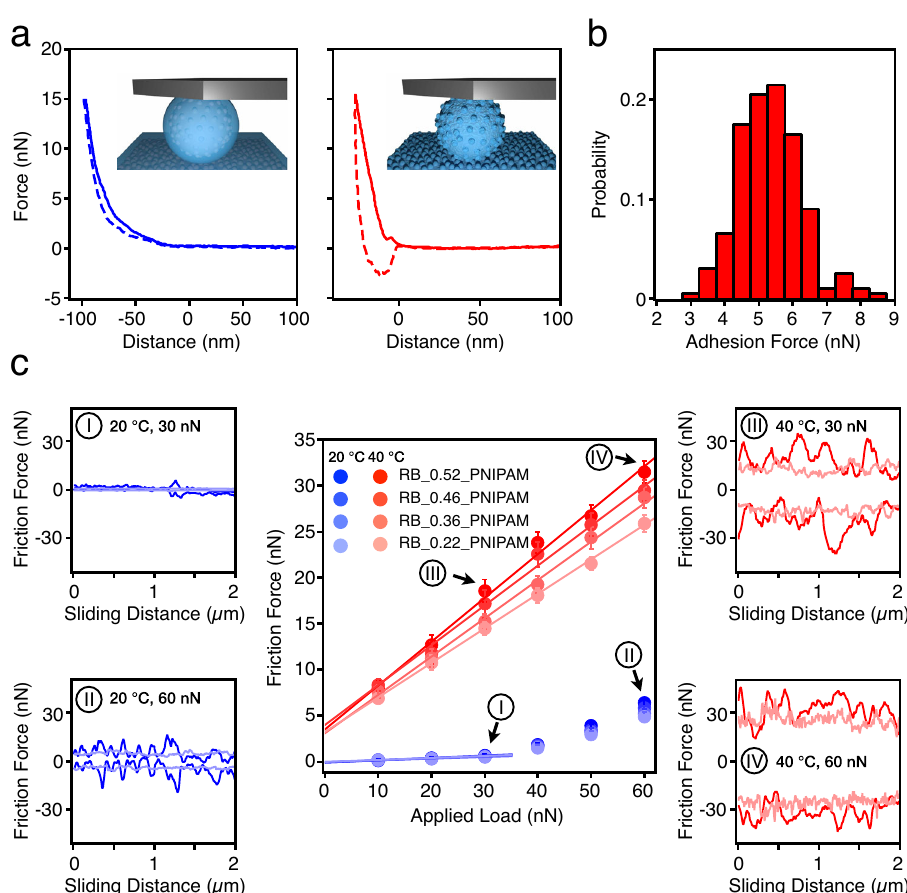
Fig. 4 Nanotribology experiments on PNIPAM-grafted rough particles. a Approach (solid line) and retraction (dashed line) of the force – distance curves of RB_0.52_PNIPAM system at 20 °C (left) and 40 °C (right). The zero-point is determined as the point at which the approach curve shows non-zero vertical de fl ection due to interaction with the substrate. The top two insets show the schematics of a RB_0.52_PNIPAM probe on a countersurface at 20 °C (left) and 40 °C (right). b The adhesion forces measured at 40 °C. The bin width is 0.5 nN. c Friction force versus applied load measurements of RB_0.22_PNIPAM, RB_0.36_PNIPAM, RB_0.46_PNIPAM, and RB_0.52_PNIPAM at 20 °C (blue) and 40 °C (red). Error bars represent the standard deviations across the scan area (51 data points). Friction loops of the RB_0.22_PNIPAM and RB_0.52_PNIPAM system at 30 nN applied load and 20 °C (I); at 60 nN and 20 °C (II); at 30 nN and 40 °C (III); at 60 nN and 40 °C (IV).